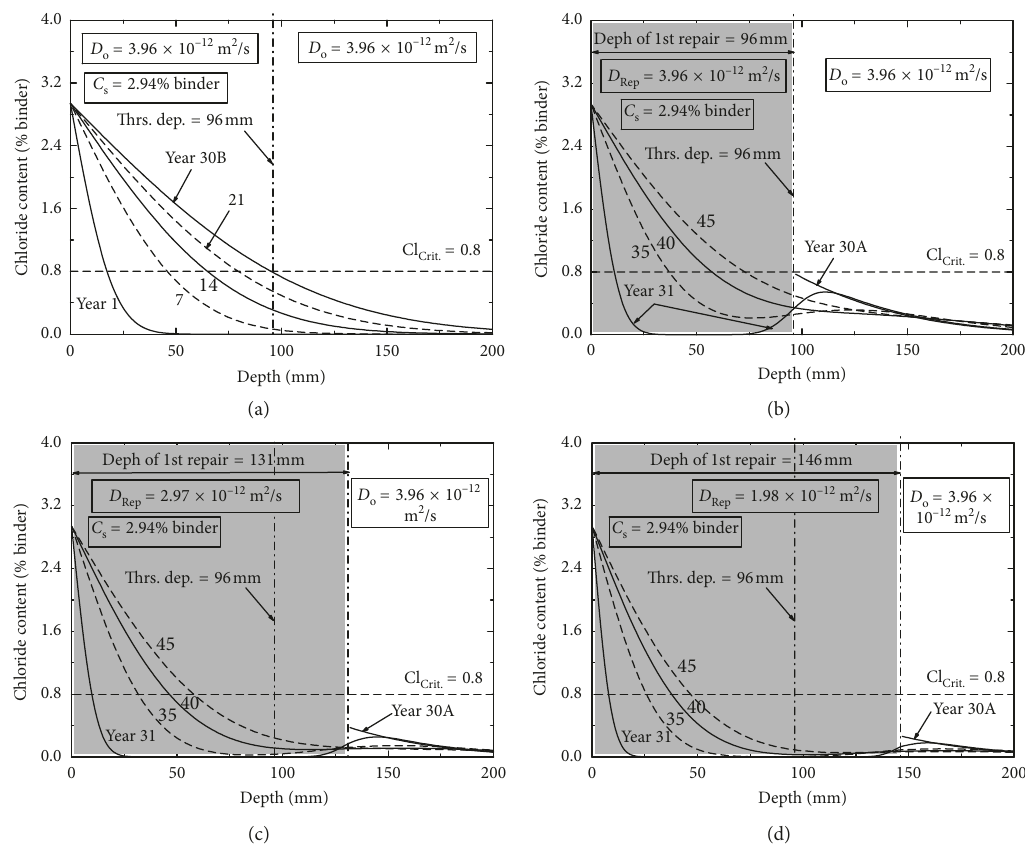
Figure 4: Deterministic space-dependent chloride profiles with S1, S4, and S6. (a) Year 1 to year 30B. (b) Year 30A to year 45 (with S1). (c) Year 30A to year 45 (with S4). (d) Year 30A to year 45 (with S6).